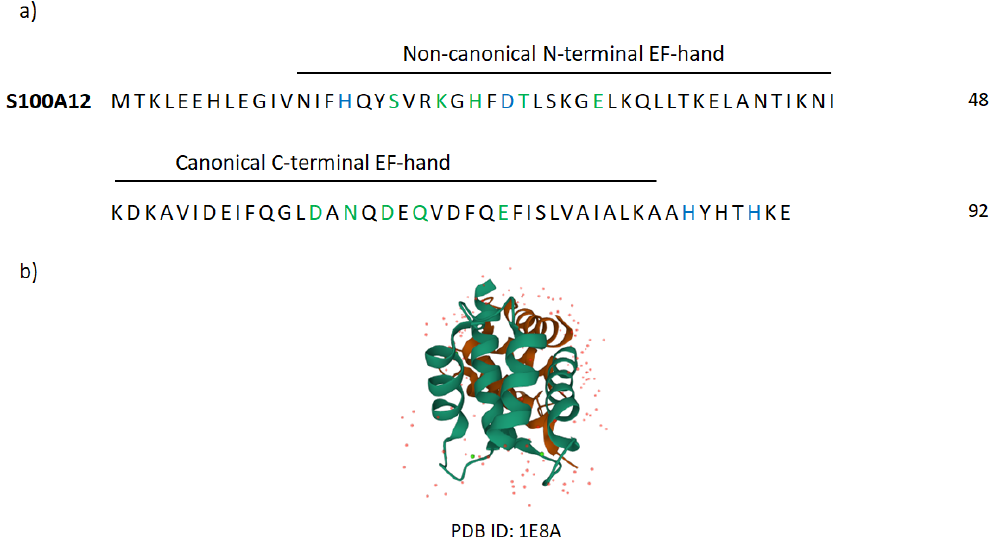
Figure A5. Structures of S100A12 protein: ( a ) predicted amino acid sequence of the human S100A12 (the blue color marks those amino acids that bind both Zn 2+ and Ca 2+ , while the green color marks the amino acids that bind only Ca 2+ ); ( b ) structure of human S100A12 protein—image from the RCSB PDB (rcsb.org) of PDB ID 1E8A [275].